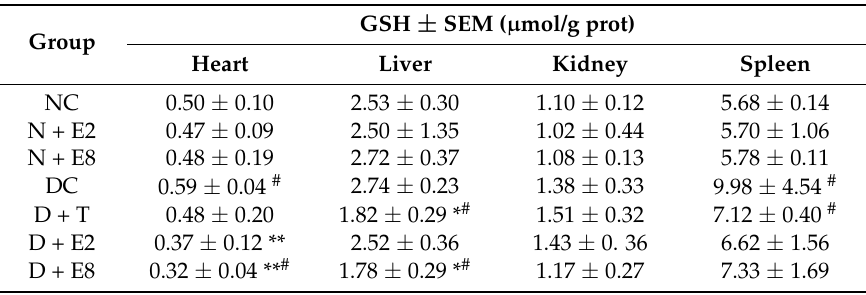
Table 2. Effects of ECE on GSH levels in organs of normal and diabetic rats.